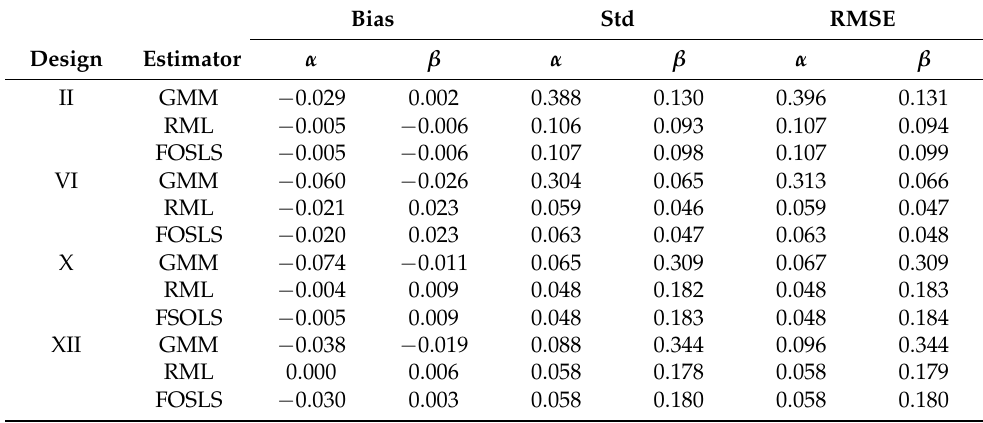
Table 4. Bias, standard deviation and RMSE of estimators for Kiviet (1995) model with a covariate, N =